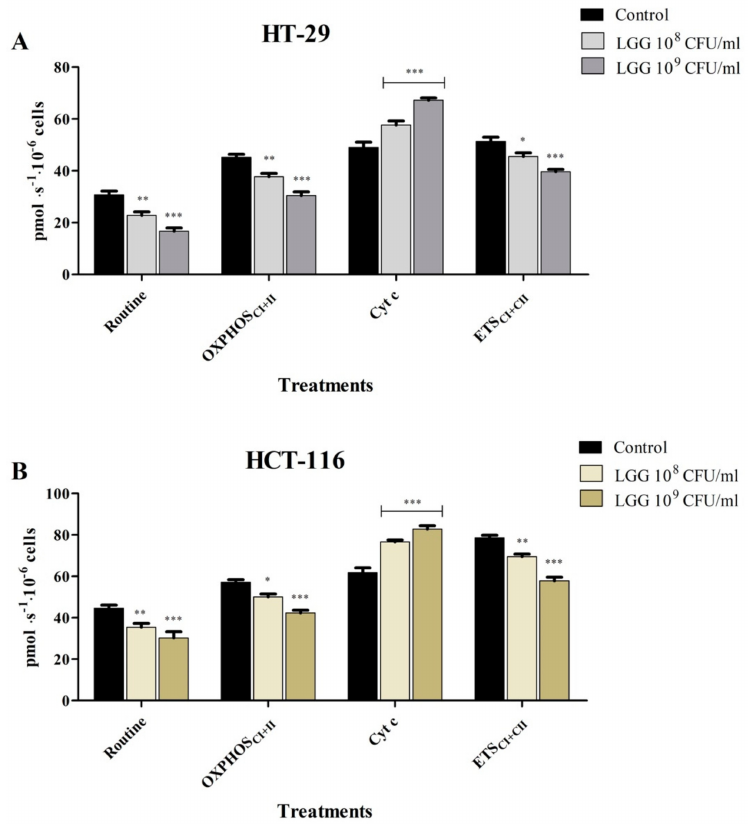
Figure 6. Mitochondrial respiratory rates (O 2 consumption) of HT-29 ( A ) and HCT-116 ( B ) cells after 48 h treatment with LGG 10 8 and 10 9 CFU/mL. The experiments were performed in triplicate and the results are presented as mean values ± SD. Values with p < 0.05 were considered to be statistically different (* p < 0.05, ** p < 0.01 and *** p < 0.001). The respiratory parameters displayed represent the following: Routine —respiration in a substrate-free media, based on endogenous substrates; OXPHOS CI+II —the maximal active respiration driven by both CI and CII; Cyt c—evaluation of mitochondrial membrane integrity and ETS CI+II —the maximal respiratory capacity of the electron transport system in the fully noncoupled